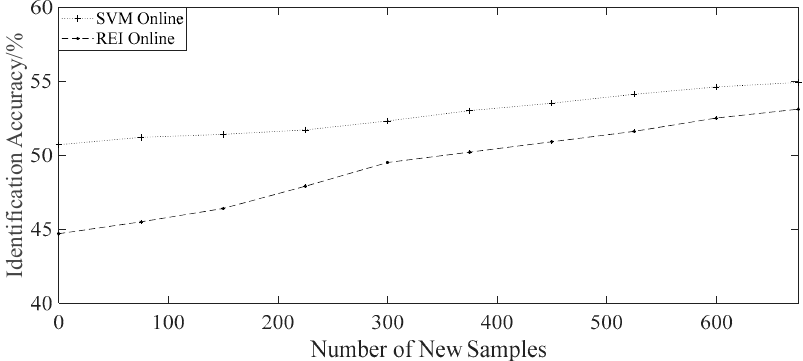
Figure 6. Identification accuracy of contrast experiment in the online learning scenario.